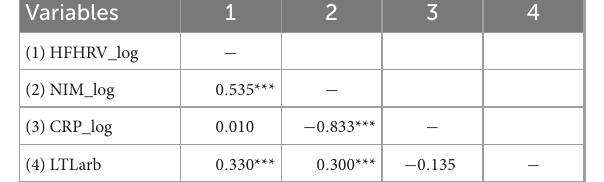
TABLE 6 Hierarchical regression models for HFHRV and CRP as predictors of LTL ( N =